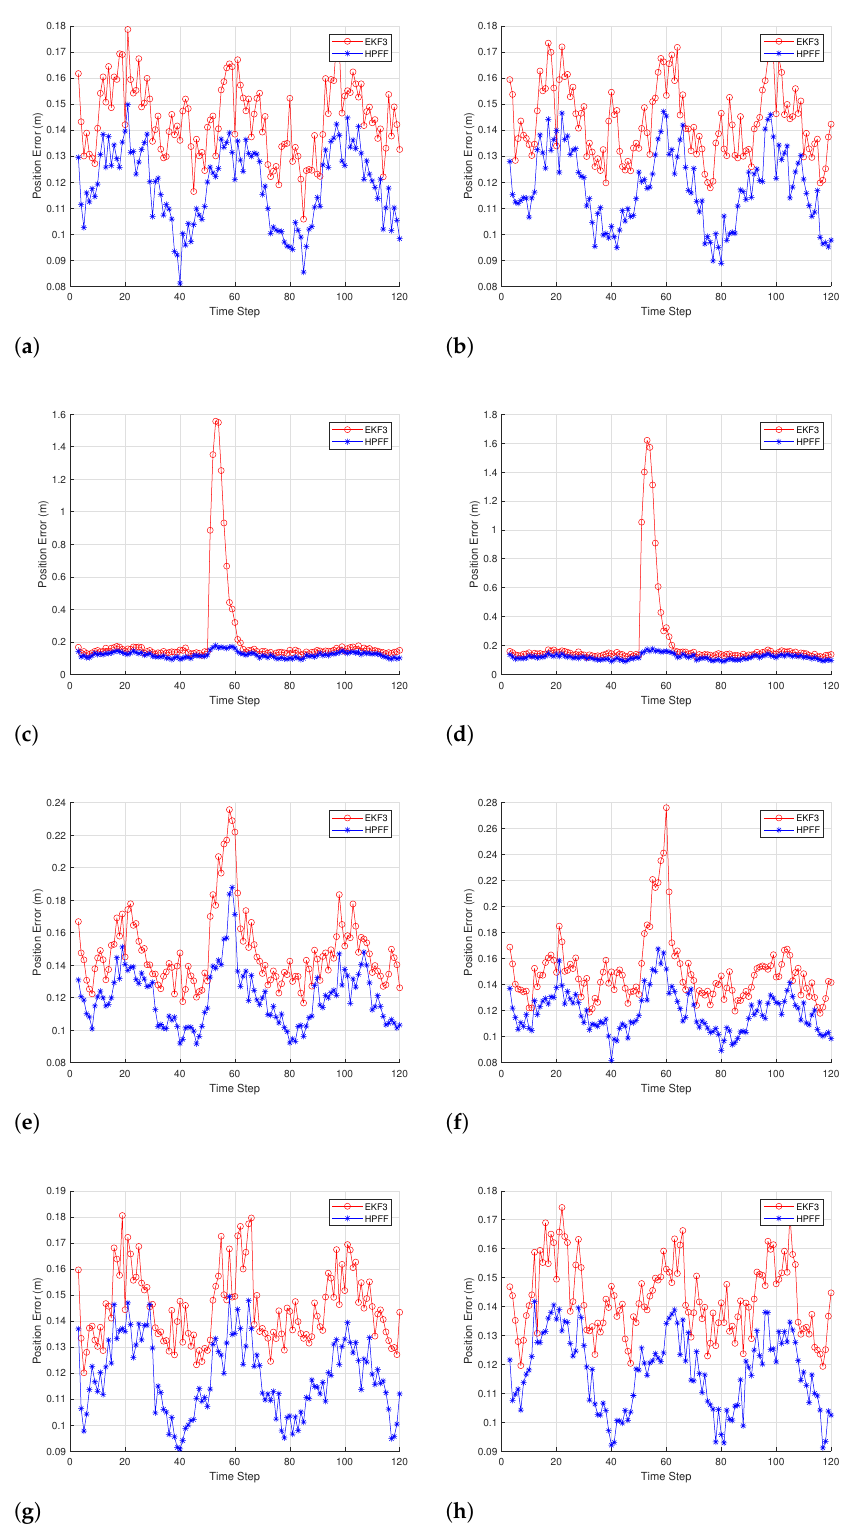
Figure 8. RMS position errors of indoor localization using HPFF and EKF3 under temporary NLOS conditions in which the transmitter (FN) in a NLOS was ( a ) FN1, ( b ) FN2, ( c ) FN3, ( d ) FN4, ( e ) FN5, ( f ) FN6, ( g ) FN7, and ( h )